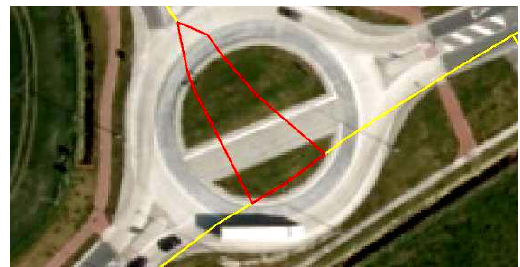
Figure 6: Redeveloped traffic circle identified by grassland detection (rejected roads = red, no decision = yellow)